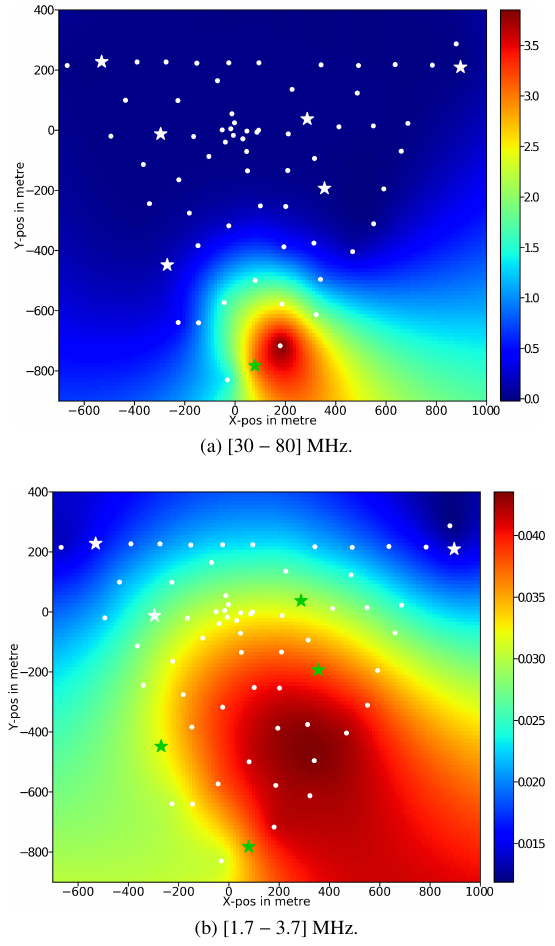
Figure 3: Ground distribution of the electric field depend- ing on the frequency range predicted by SELFAS3 [7].